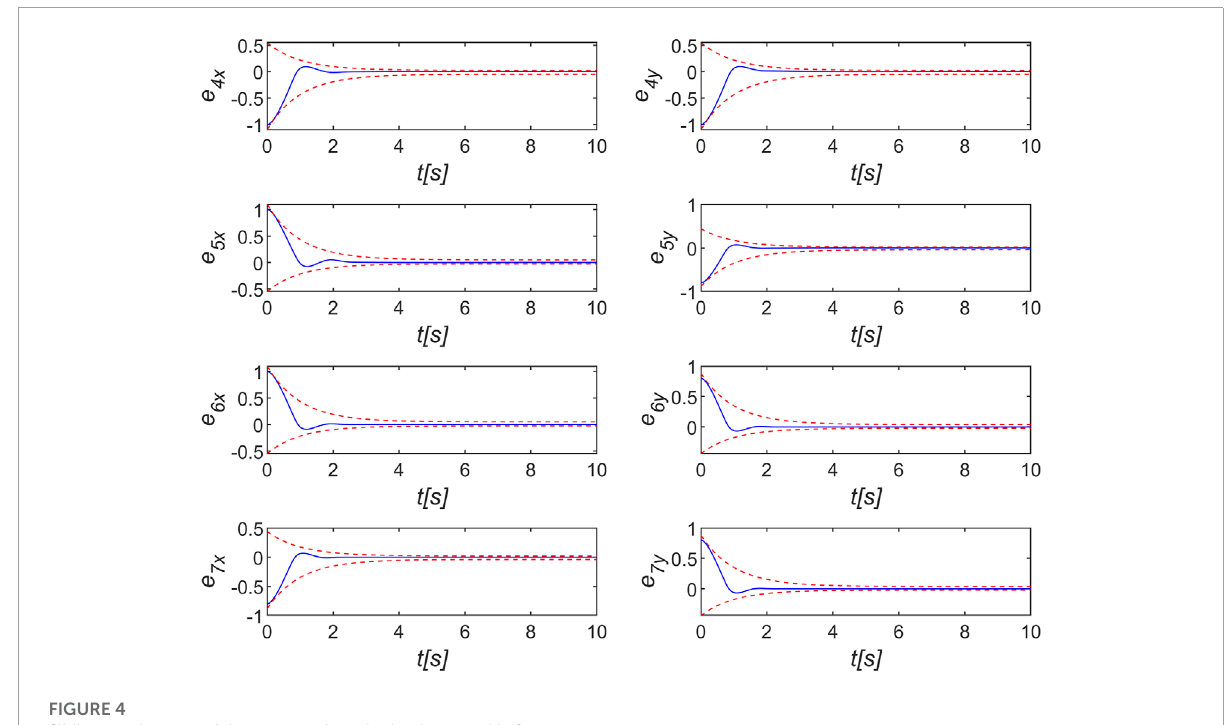
FIGURE 4 Sliding mode error of the agents when the leader speed is 0.